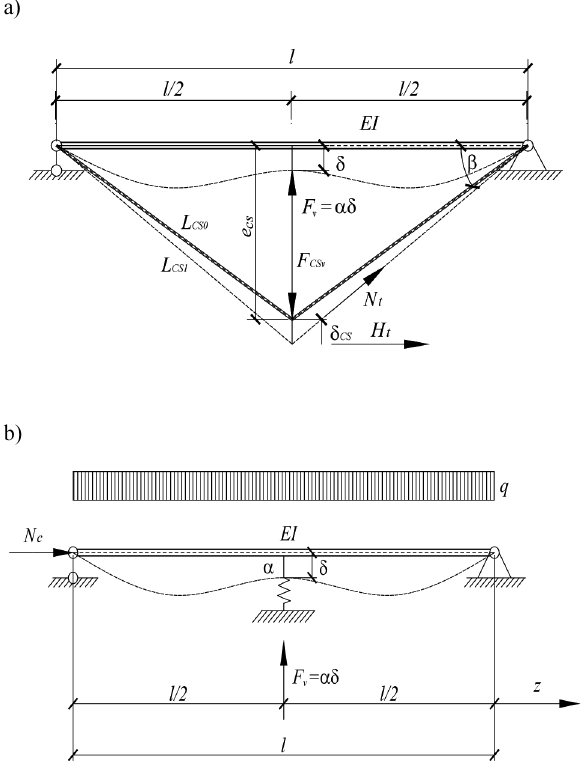
Fig. 2. The analysis of the under-deck cable-stayed bridge with the cable staying system with one strut: a) the interaction between the cable-staying system and the deck, b) calculation model of the simply supported additionally restrained conti- nuous beam simultaneously subjected to axial compression and distributed vertical load